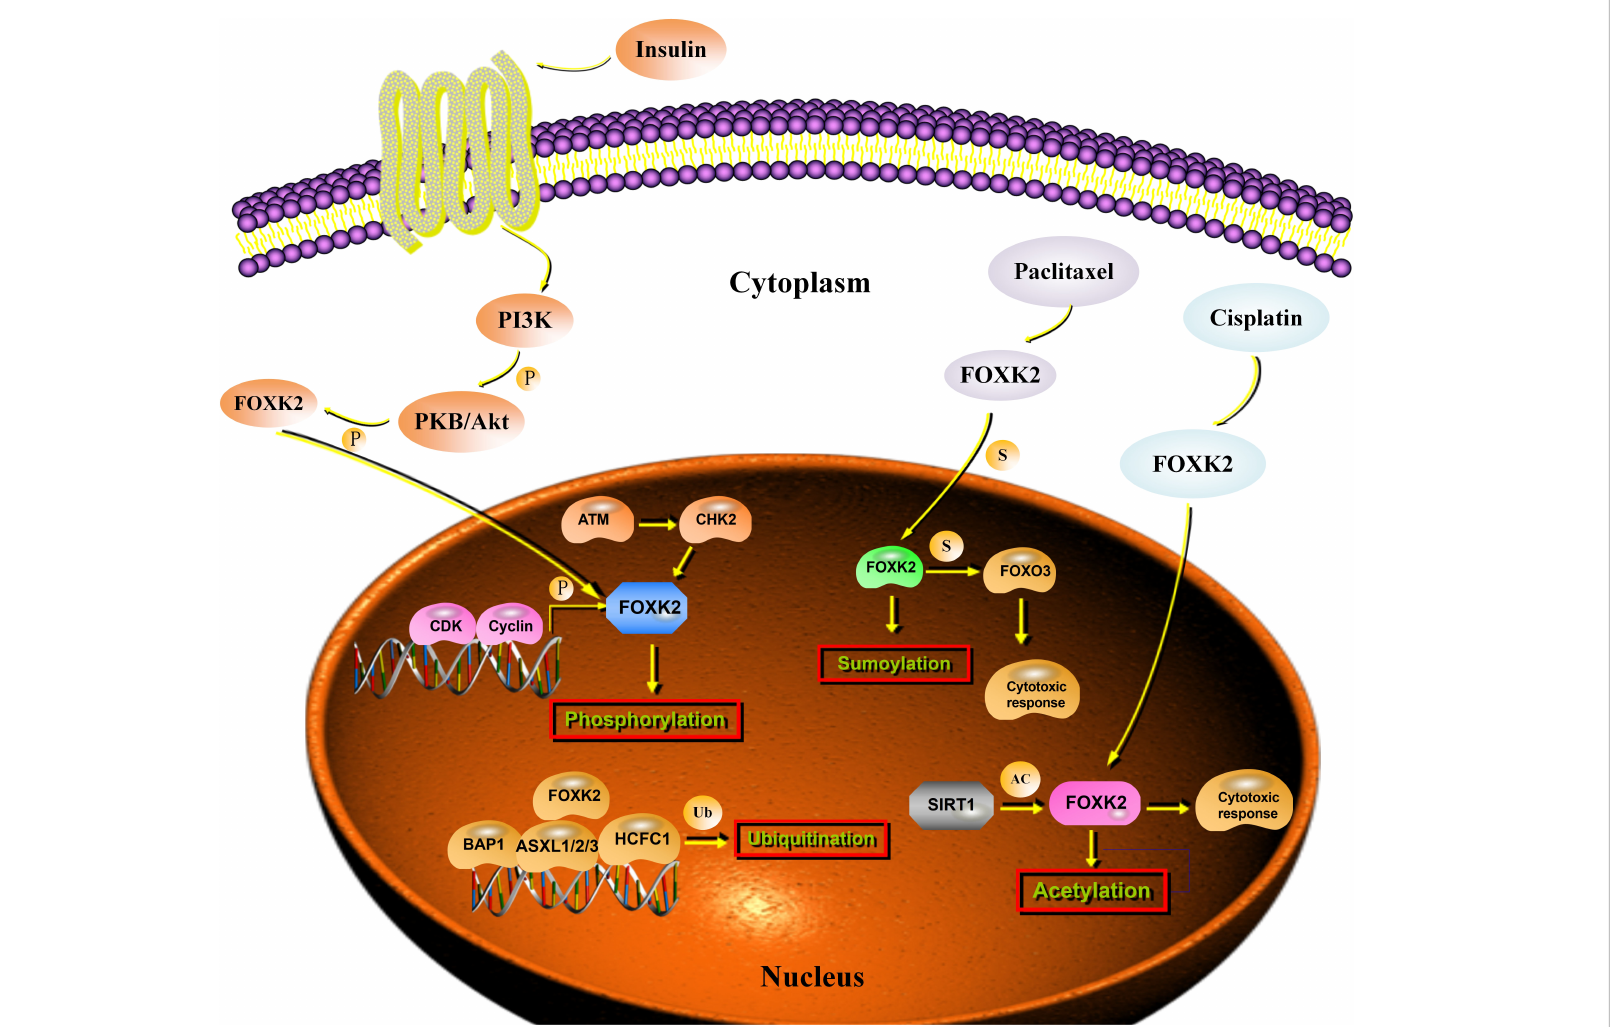
FIGURE 3 Post-transcriptional regulation of FOXK2. Stimulation with insulin results in the phosphorylation of FOXK2 through PI3K-Akt that leads to the translocation of FOXK2. CDK/cyclin complexes phosphorylate FOXK2 and promote its degradation. ATM activates CHK2, which phosphorylates FOXK2 at Ser61. BAP1 binding to chromatin depends on FOXK2. A PR – DUB complex is produced, which regulates histone H2AK119ub1 levels and transcription. Sumoylation of FOXK2 increases its transcriptional activity and mediates the cytotoxic response to paclitaxel through FOXO3a. SIRT1 inhibition enhanced FOXK2-induced chemosensitivity to cisplatin via